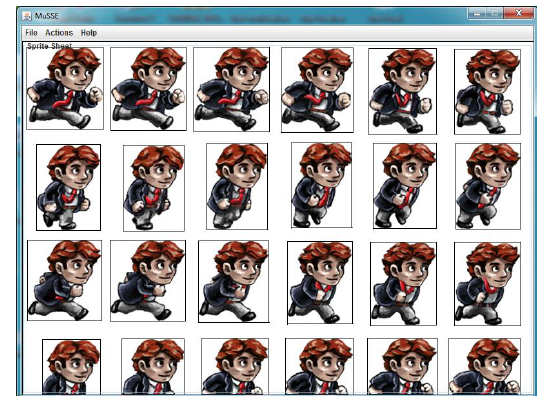
image from the game Braid©. If the user chooses Option 2, the algorithm is applied to the whole sprite sheet image. Fig. 15 illustrate the process.